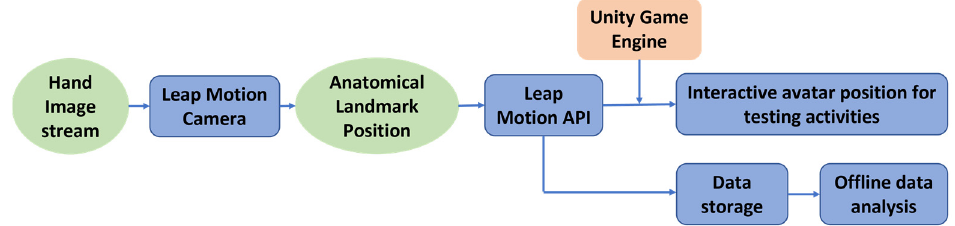
Figure 1 . Data Collection Process.